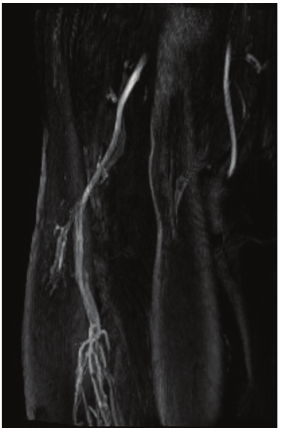
Figure 2: MRI angiogram of the popliteal fossa showing complete occlusion of the popliteal artery in the left